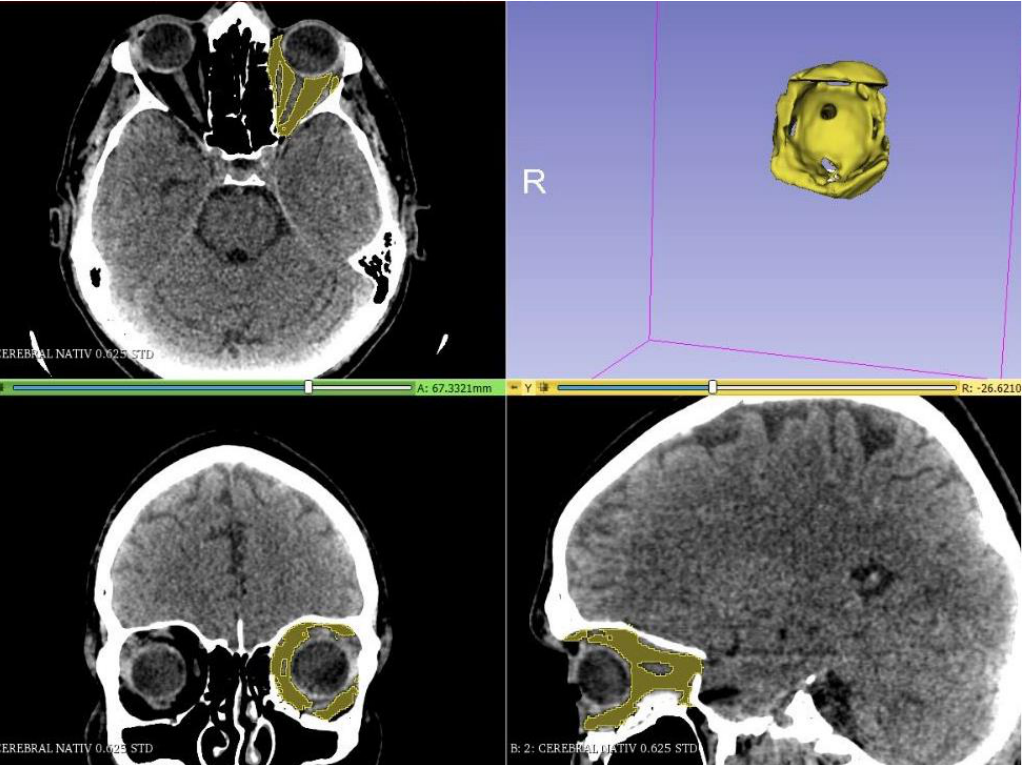
Figure 2. Segmentation of orbital fat tissue.